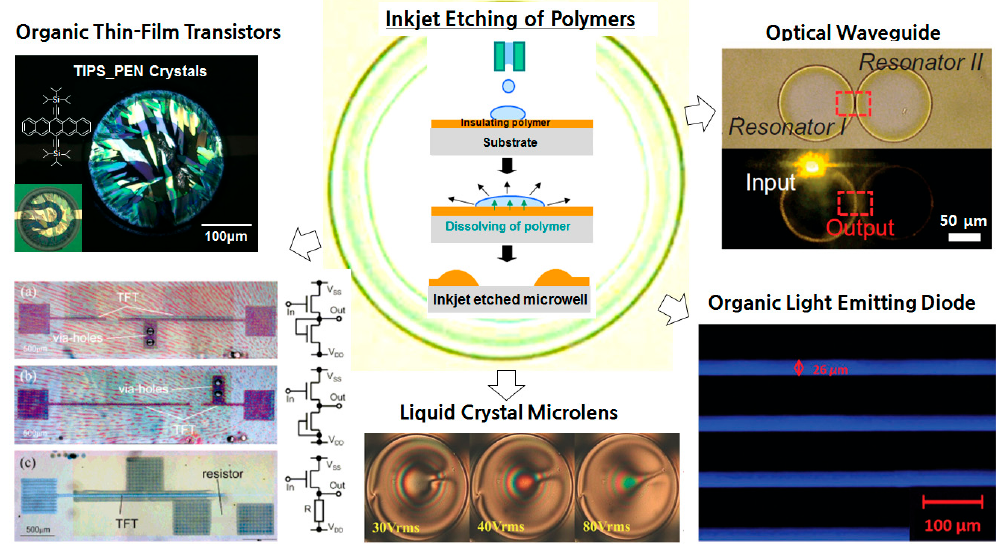
Figure 1. The applications of the inkjet etching of polymers to various organic electronic devices: an optical waveguide, an organic light emitting diode, a liquid crystal microlens, and organic thin-film transistors [11,28–31].